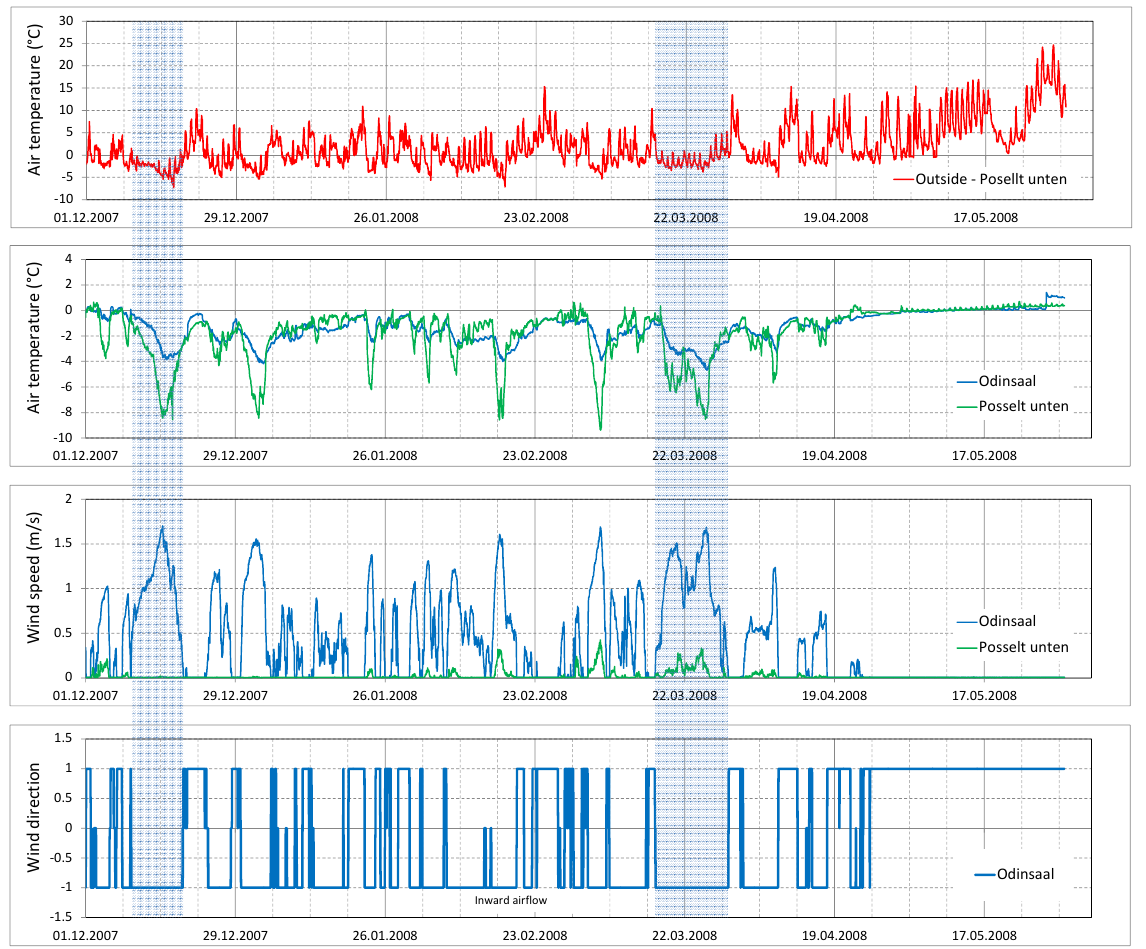
Fig. 7. Daily cycle of air temperature (hourly values) for the two AWS-locations Posselthalle and Odinsaal as well as the weather-station outside the cave Eisriesenwelt for the period 26 July 2008 to 15 August